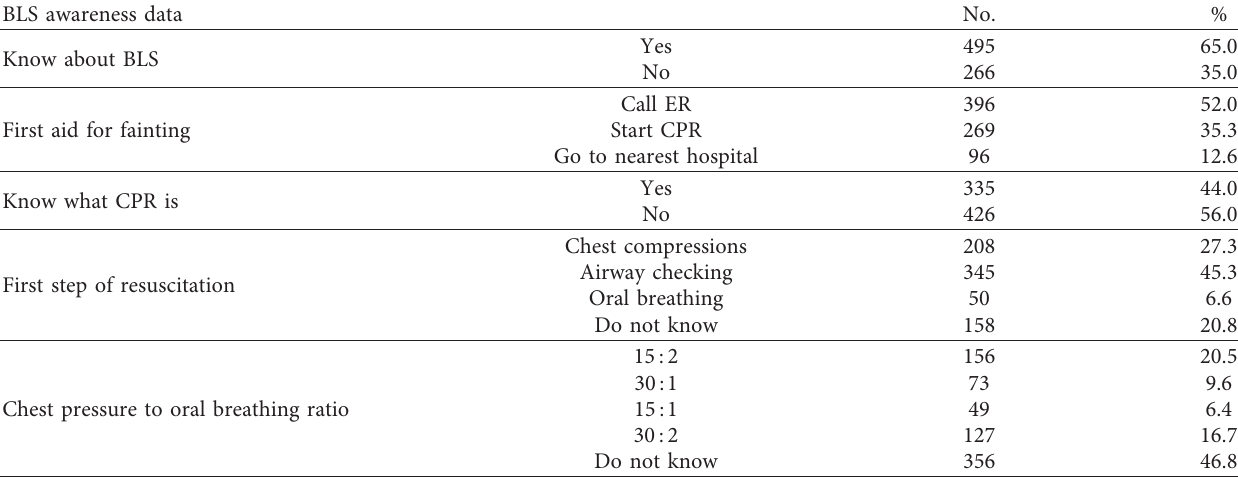
Table 3: BLS awareness recorded among secondary school students in Abha City, southern Saudi Arabia.